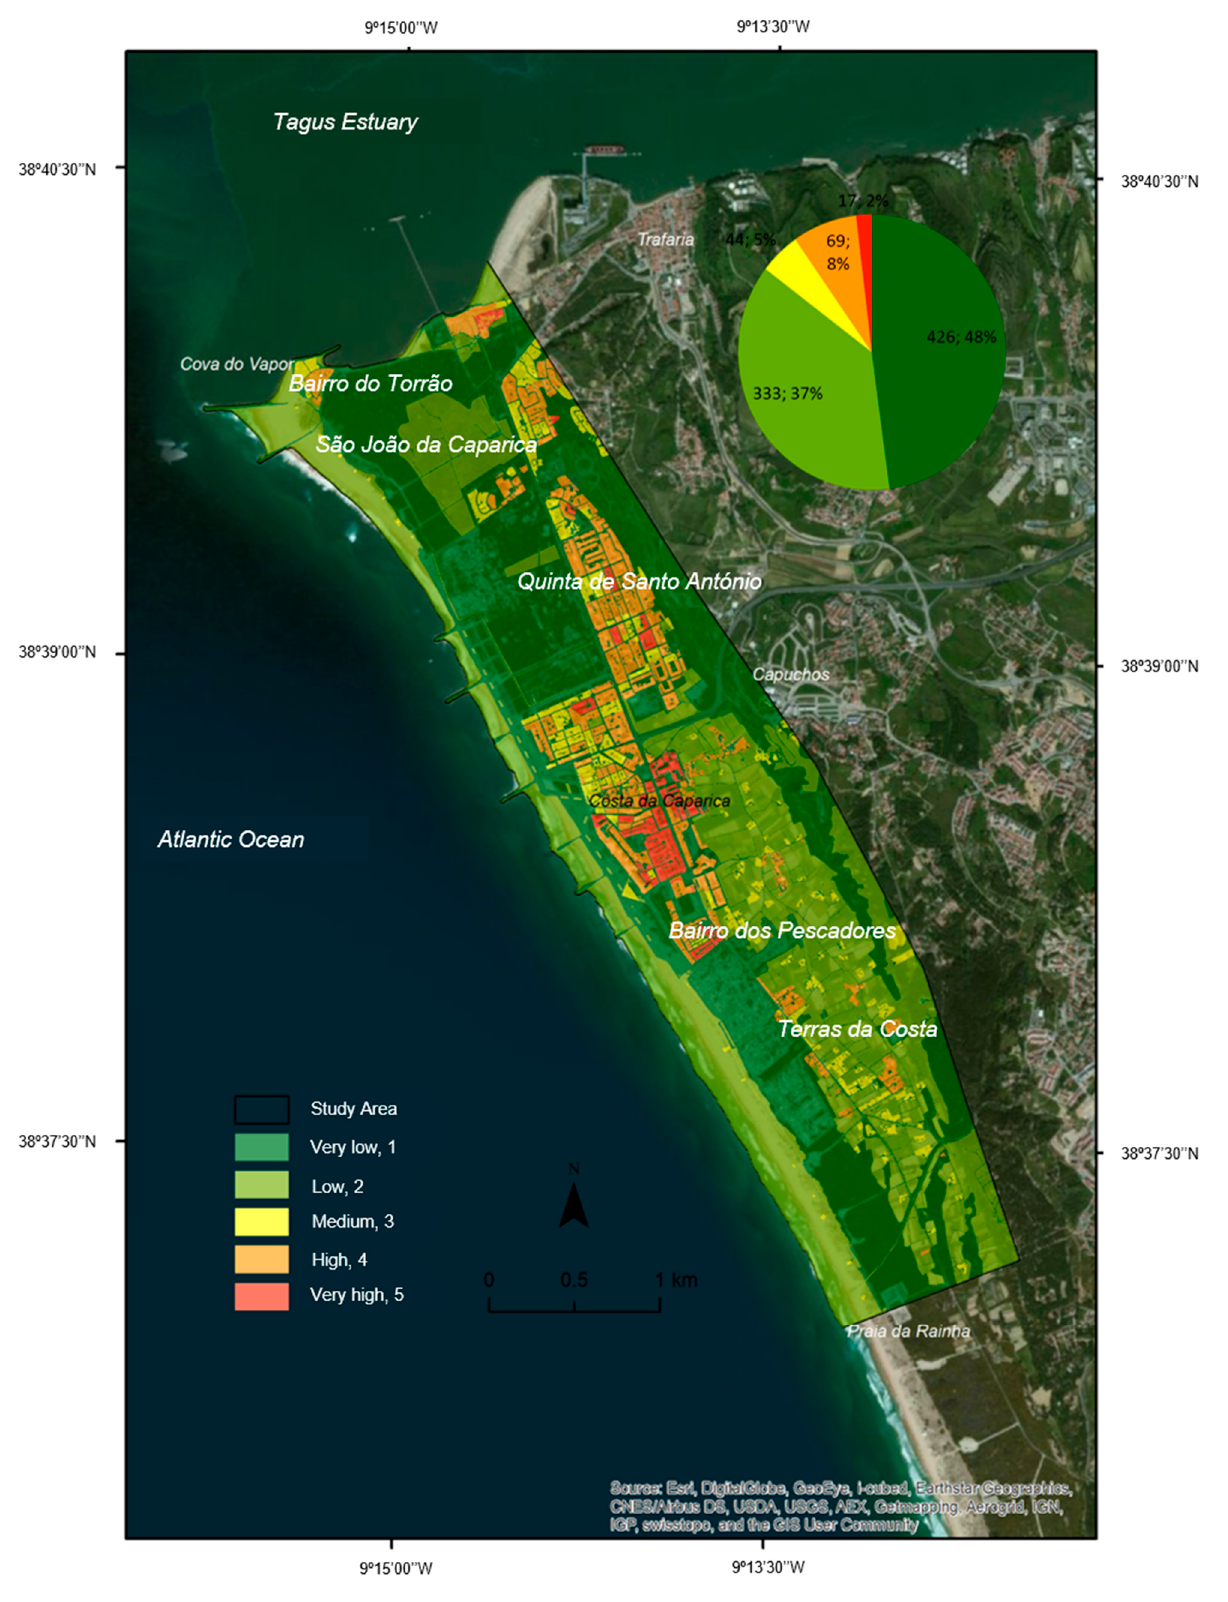
Figure 5. Map of the vulnerability index to coastal overtopping and consequent flooding in the study area, Costa da Caparica, with the graph with the areas (ha) and percentages of each class of vulnerability. The coordinate system used was the Datum73 Transverse Mercator.